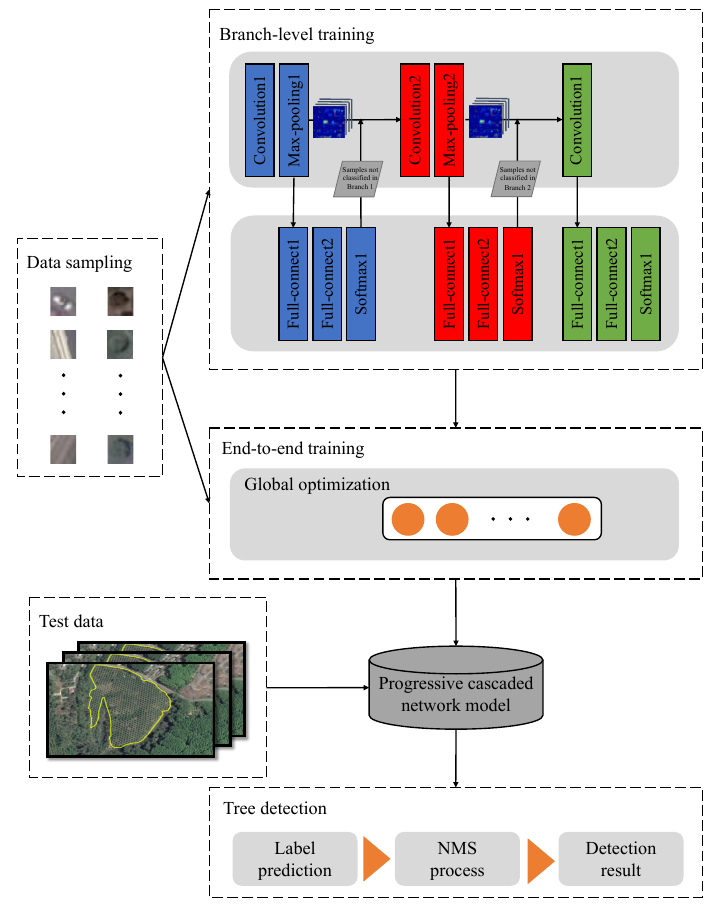
Figure 2. Flowchart of tree